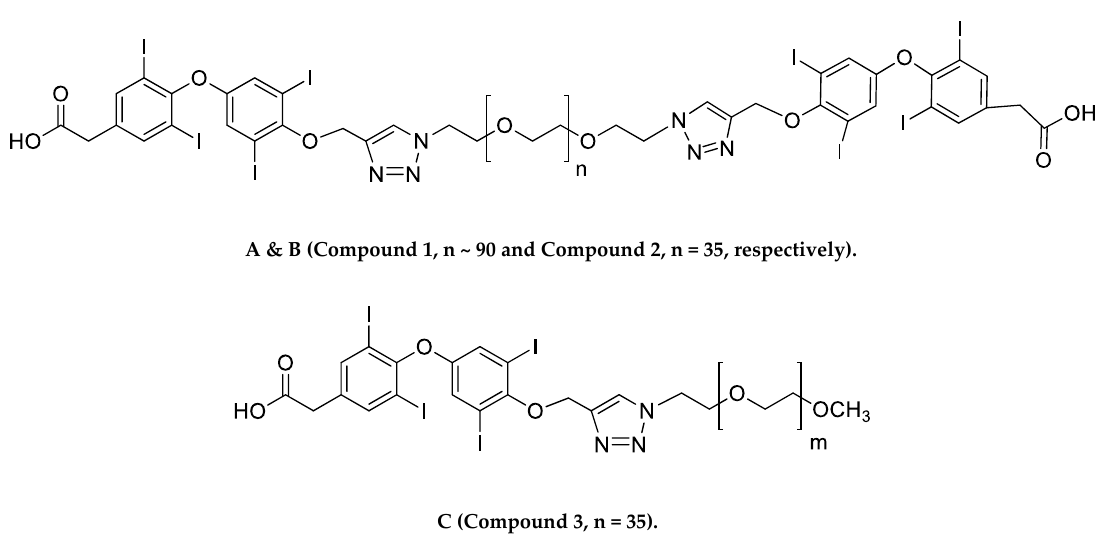
Figure 1. Schematic structures of ( A ) P 4000 -bi-TAT (Compound 1 ), ( B ) P 1600 -bi-TAT (Compound 2 ), and ( C ) P 1600 -m-TAT (Compound 3 ). In the structure, ‘n’ and ‘m’ indicate the PEG size. ( A , B ) differ in PEG size, with a molecular weight of 4000 (n ~ 90) and 1600 (n = 35), respectively.